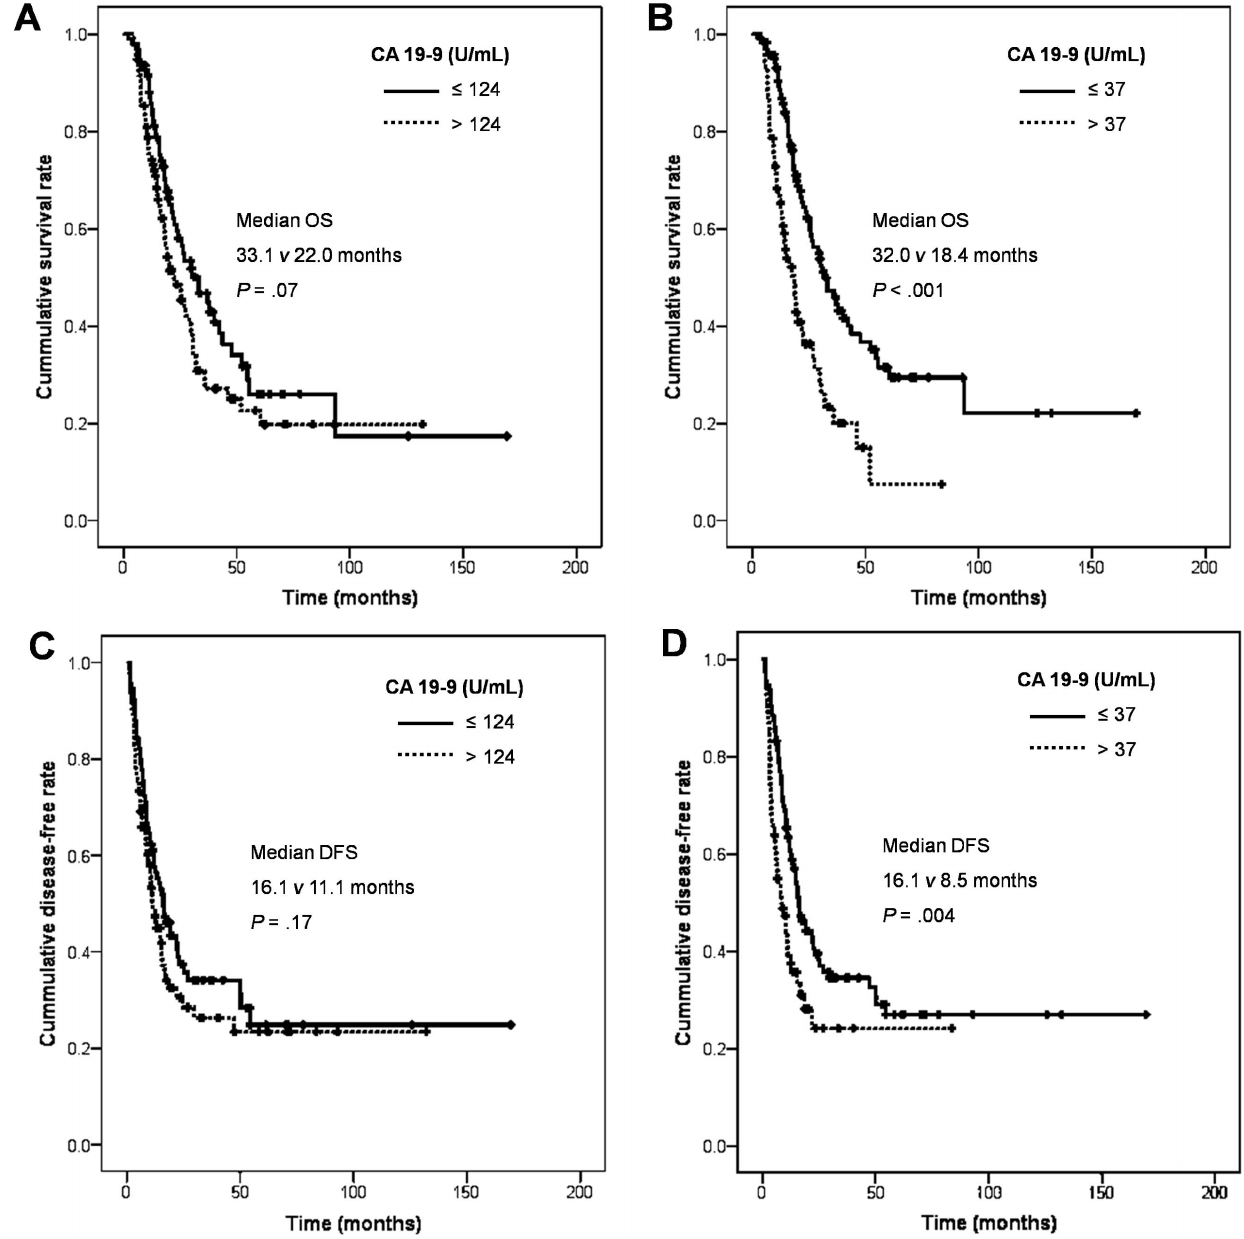
Figure 2. Kaplan-Meier curve of OS and DFS according to CA 19-9 level in R0 and R1 resection. (A, C) Initial CA 19-9 with median cut off value and (B, D) post-operative CA 19-9 with normal cut off value. Abbreviations: OS, overall survival; DFS, disease-free survival.